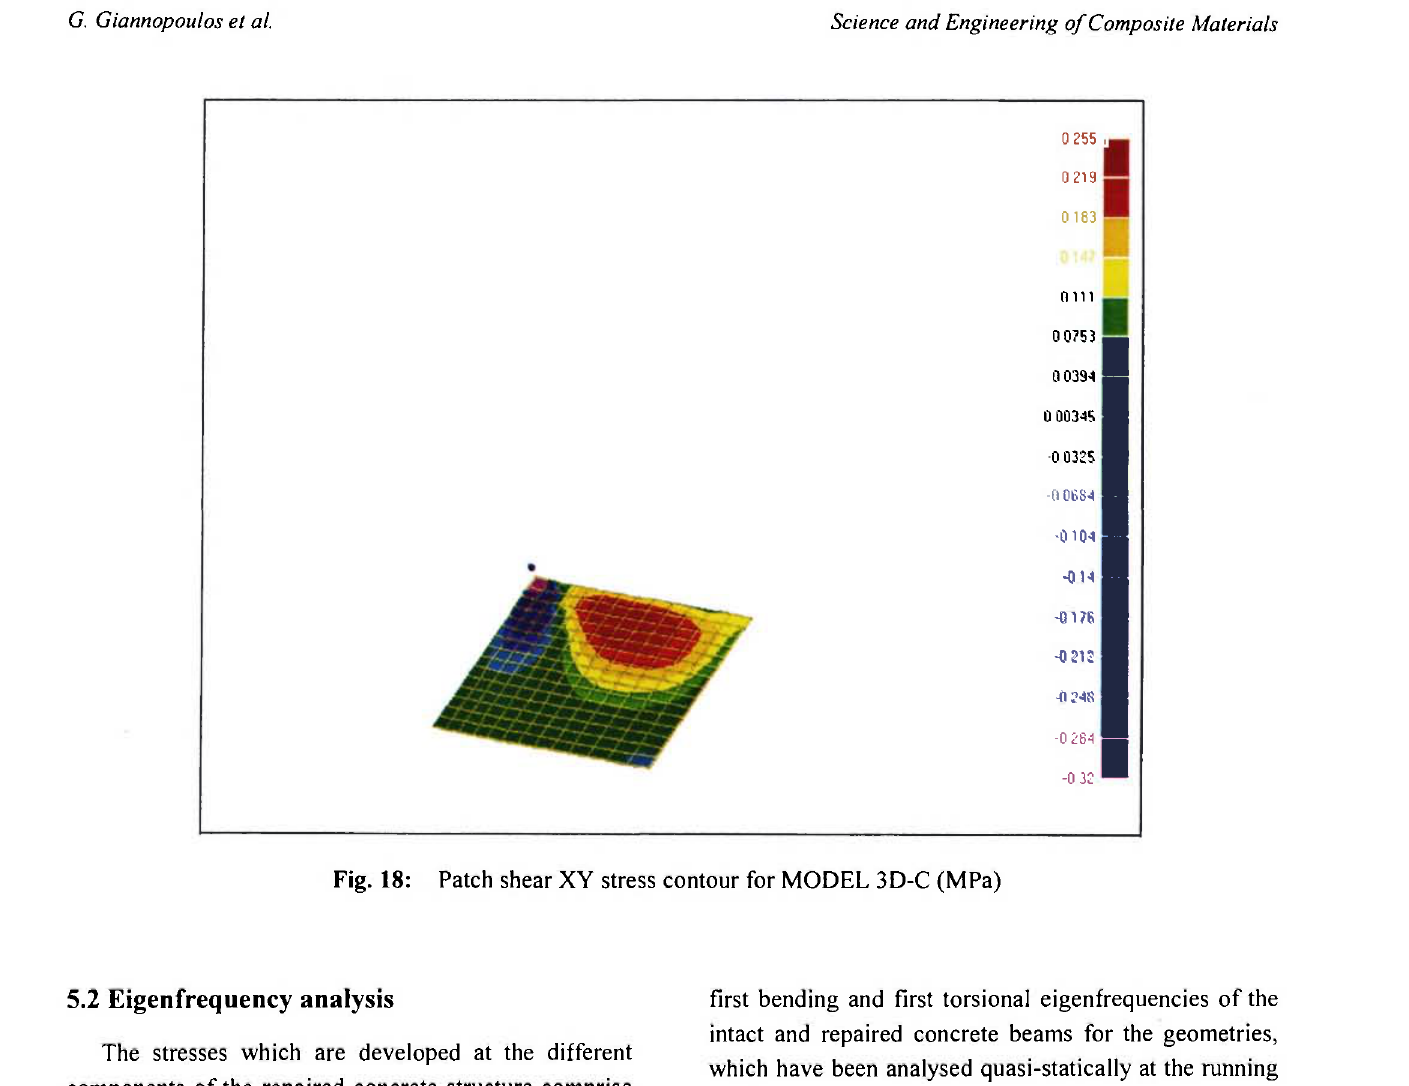
Fig. 18: Patch shear XY stress contour for MODEL 3D-C